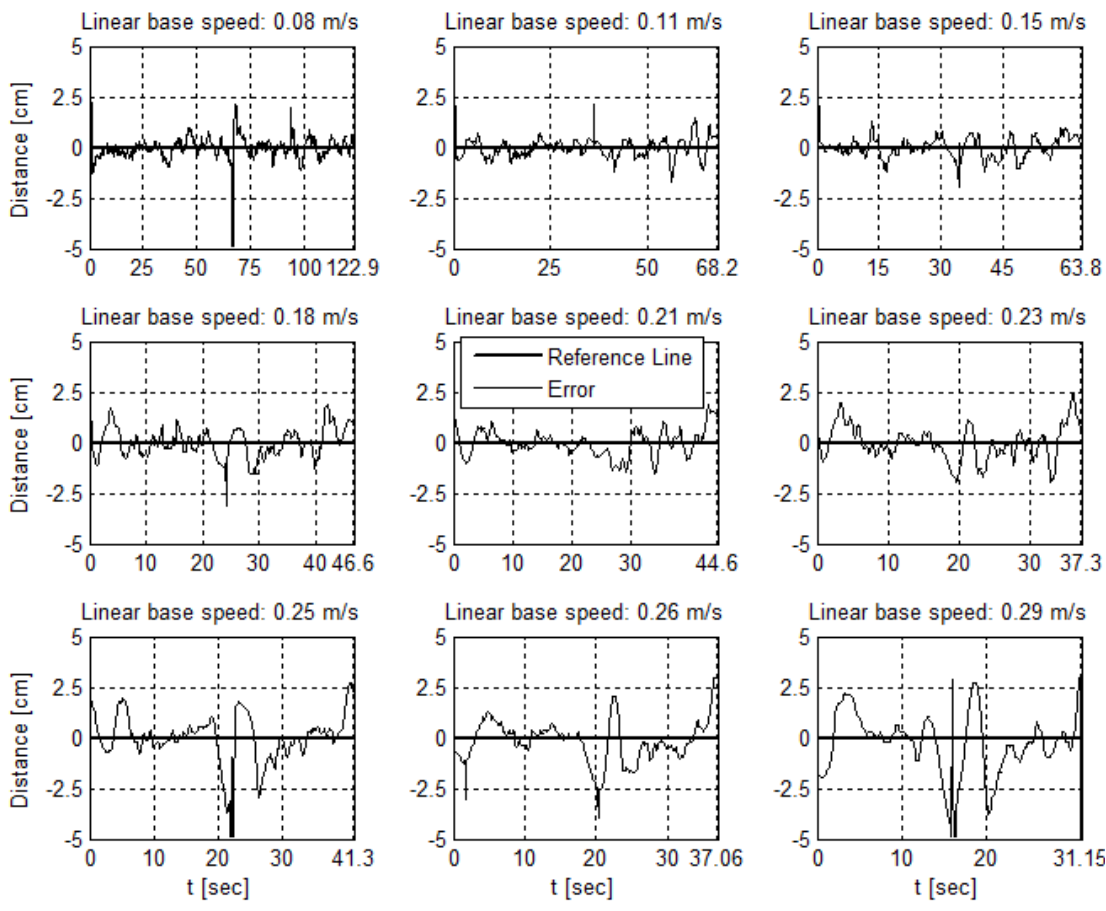
Figure 28. A cycle of distance measurements at each AGV linear base speed.